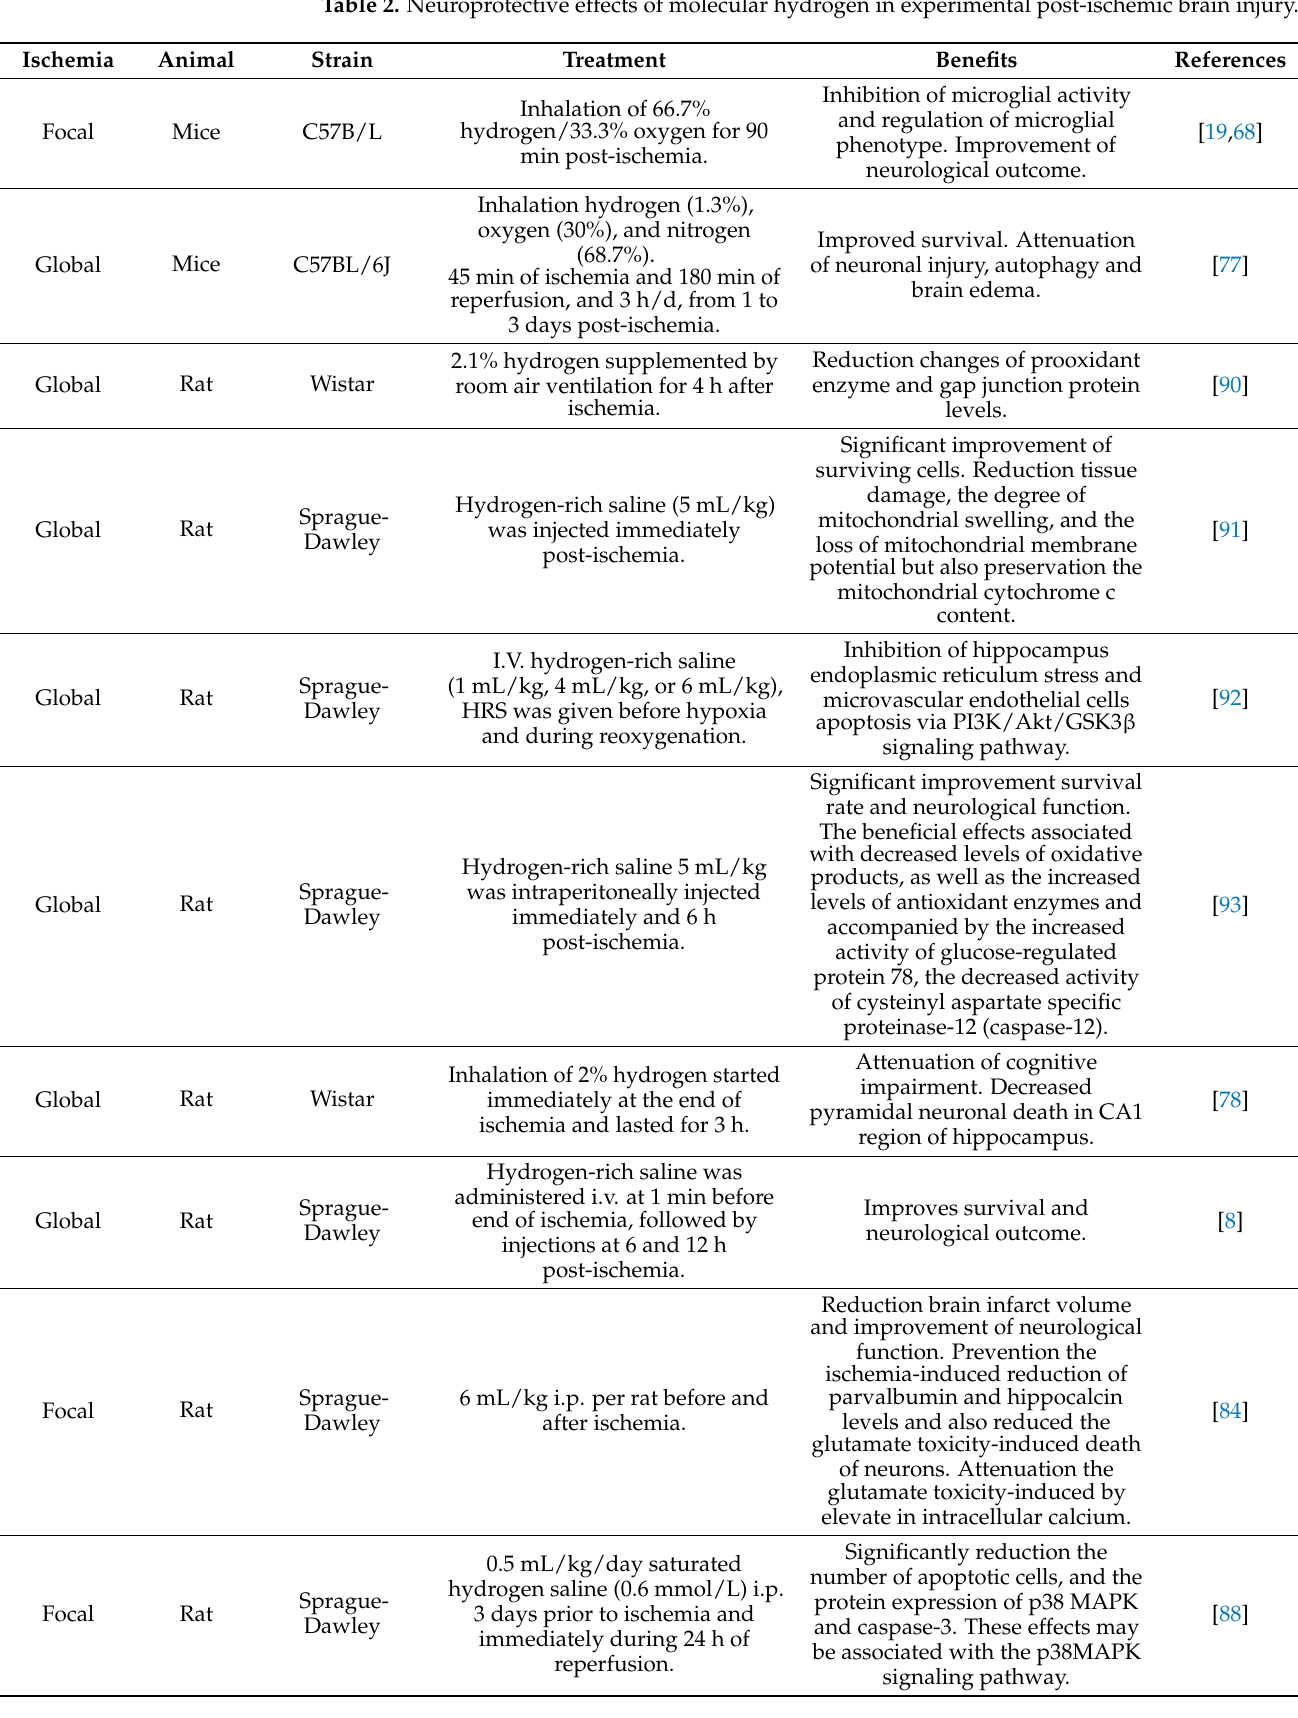
Table 2. Neuroprotective effects of molecular hydrogen in experimental post-ischemic brain injury.